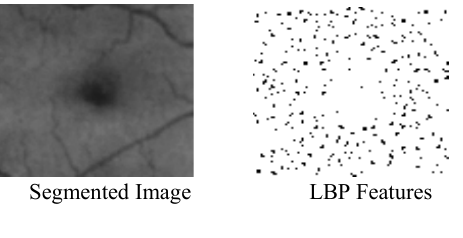
Figure 8. Pre-processed Image Samples